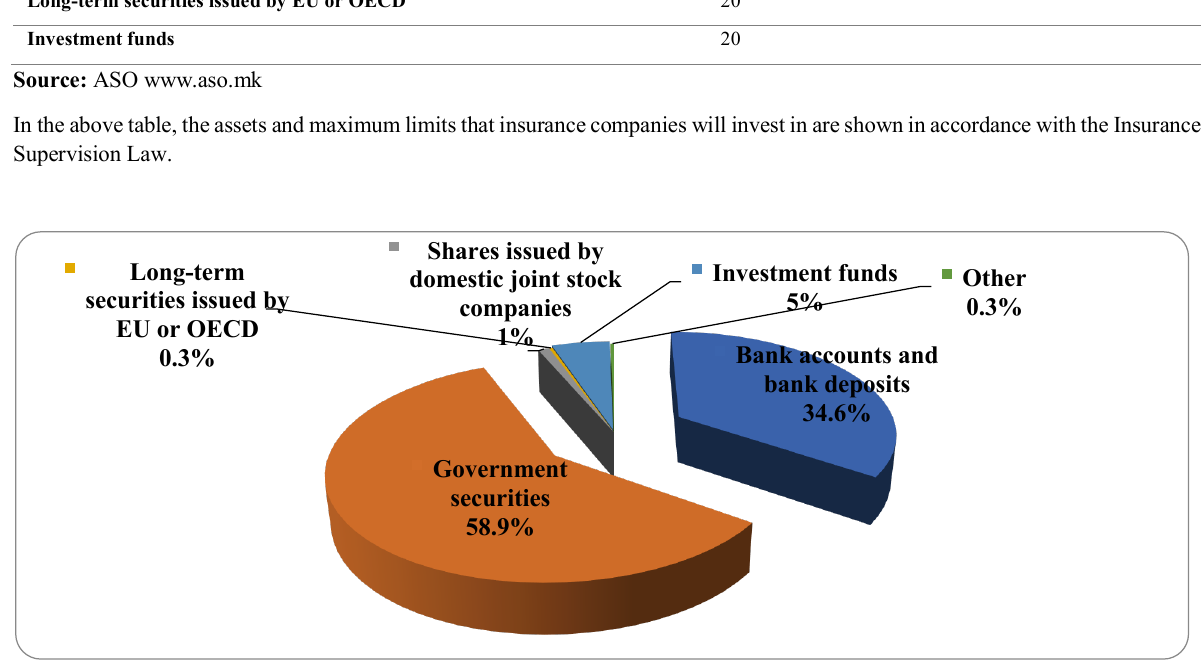
Figure 4. Investment tools and their rates used by the insurance companies 31.12.2018; Source: ASO